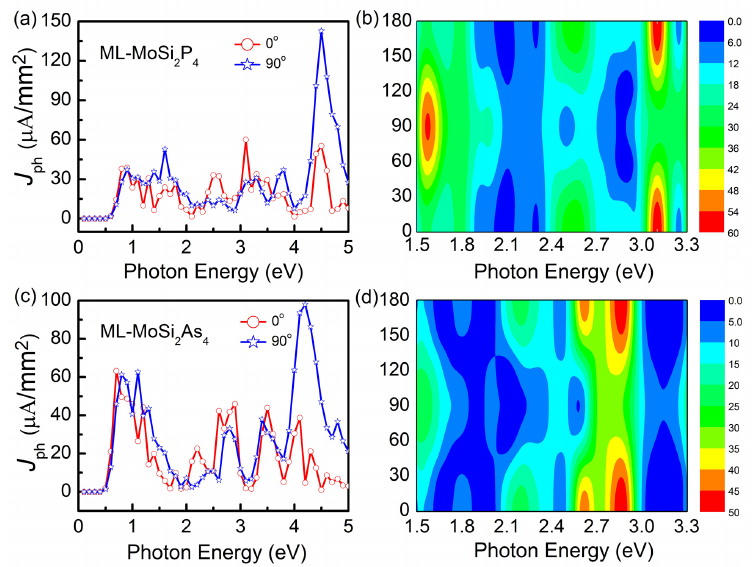
Figure 8. Photocurrent as a function of photon energy with polarization angle θ of the incident light equal to 0 ◦ and 90 ◦ for monolayer ( a ) MoSi 2 P 4 and ( c ) MoSi 2 As 4 nanodevice. ( c , d ) show the photocurrent versus photon energy and θ for monolayer ( b ) MoSi 2 P 4 and ( d ) MoSi 2 As 4